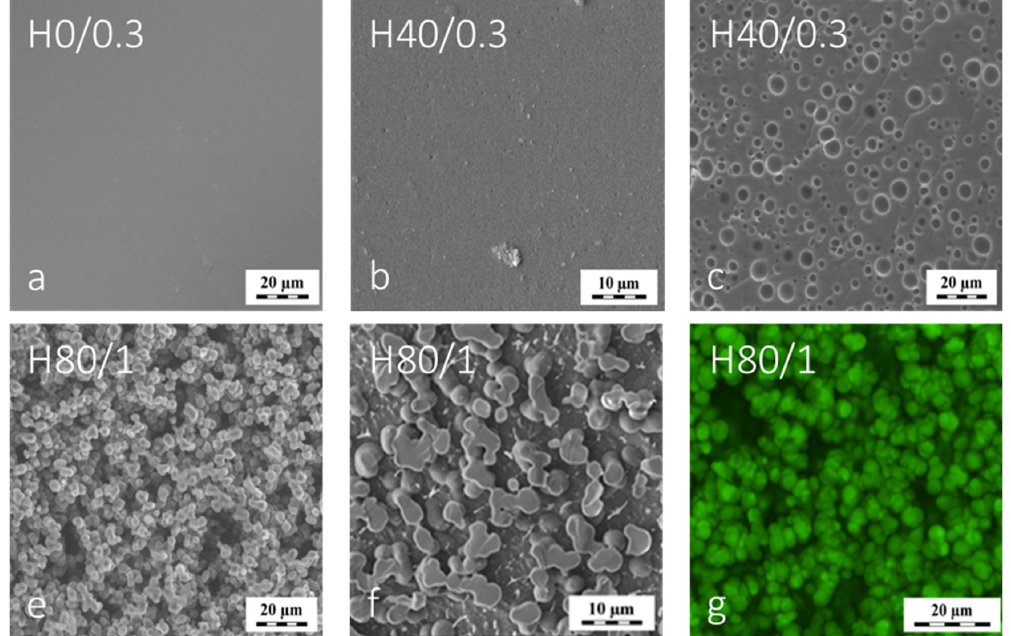
Figure 5. Micrographs of various hydrogels prepared from lightly crosslinked PHEMA. Figures a,b,c show microstructure of macroscopically clear gels by cryo-SEM and HVSEM: ( a ) cryo-SEM of H0 / 0.3 and ( b , c ) HVSEM and cryo-SEM of H40 / 0.3 produced below critical water dilution. Figures ( d , e , f ) show micrographs of H80 / 1 hydrogel by ( d ) cryo-SEM, ( e ) HVSEM and ( f ) LSCM.